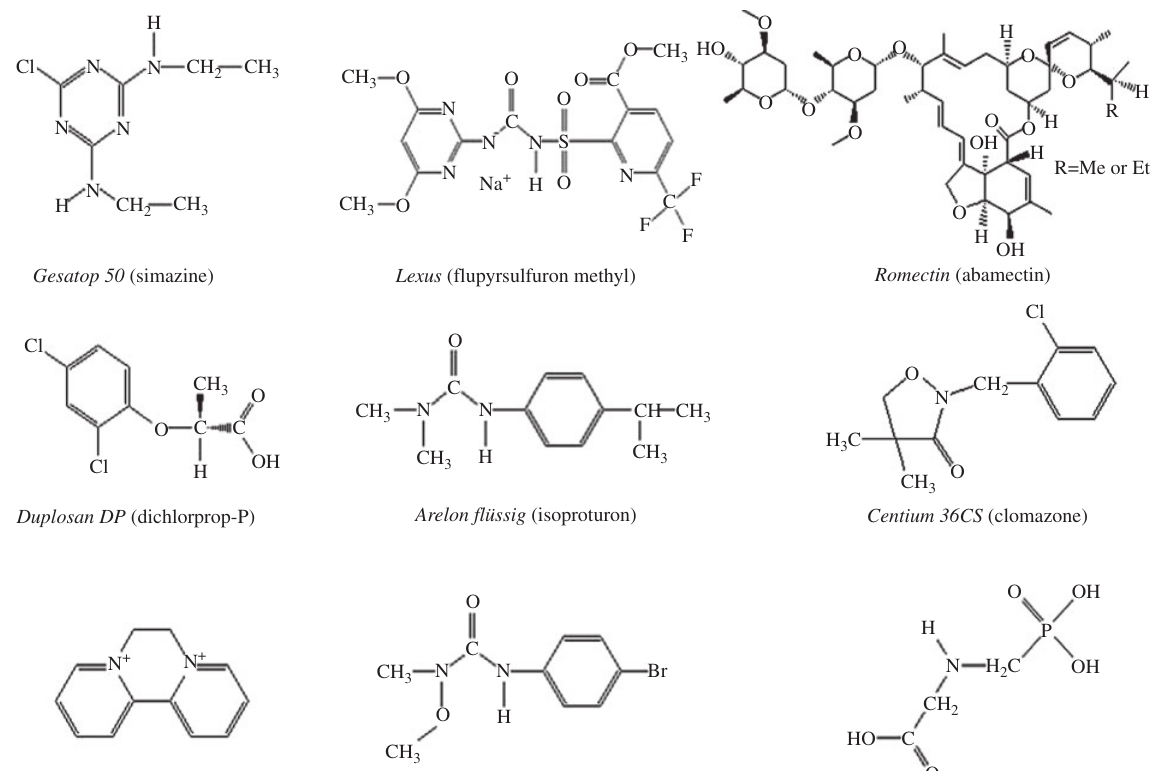
Figure 12 Pesticide molecular structures.